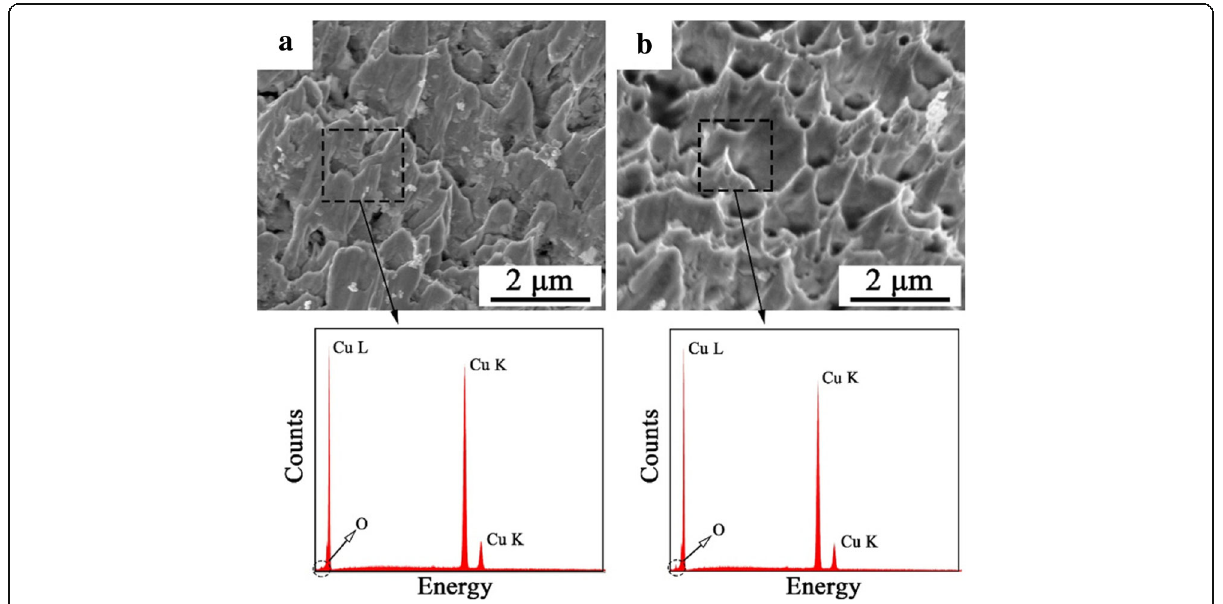
Fig. 4 The fracture surfaces of the Cu – Cu bonding interface a after bonding at 300 °C and b after aging test and the corresponding EDX